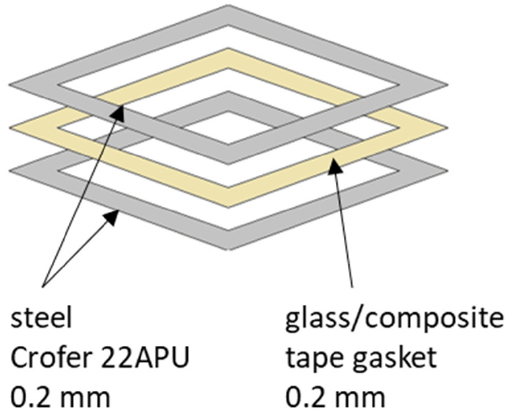
Figure 1. Diagram of a sample in the form of a composite frame sandwiched between Crofer 22APU steel.